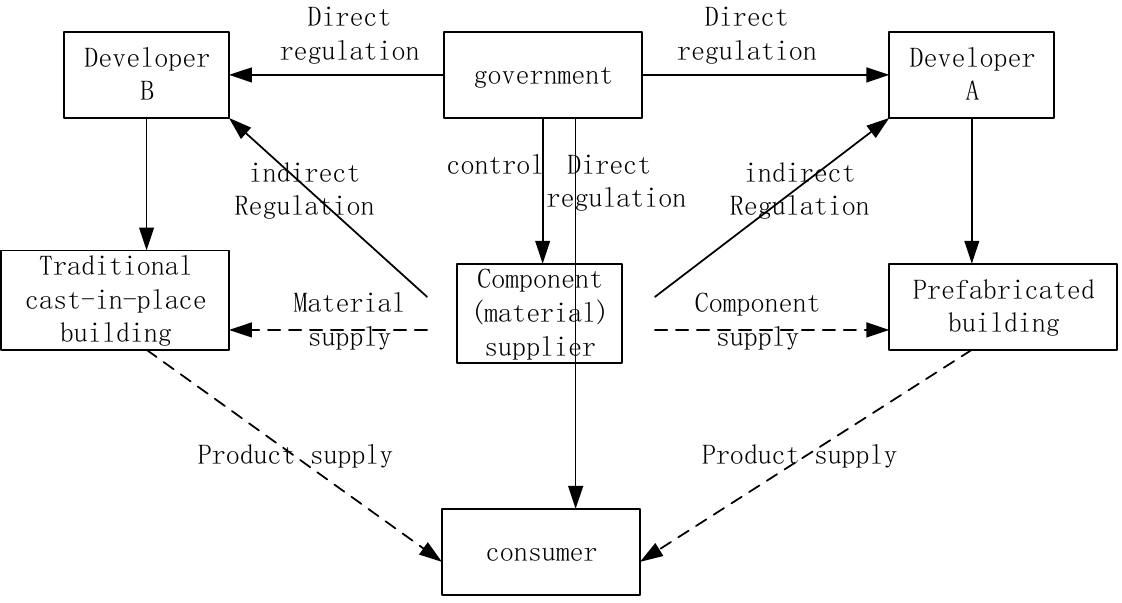
Figure 1. Stakeholder regulation diagram.